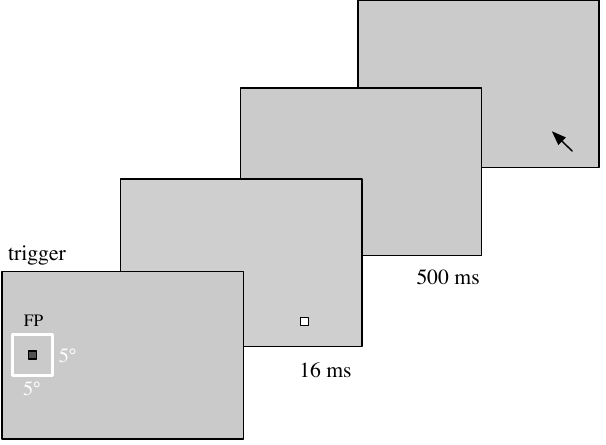
Figure 5 . Fixation localization judgements. The subject fix- ated FP for a variable time between 1500 and 2300 ms. Gaze was triggered to a 5 x 5 deg window centered around FP. A computer voice and the slightly violet color of FP instructed the subject that a fixation trial was starting. Then a 16 ms long flash appeared at one of the 34 testing positions. Subjects had to maintain fixation until after the localization report with the mouse pointer was